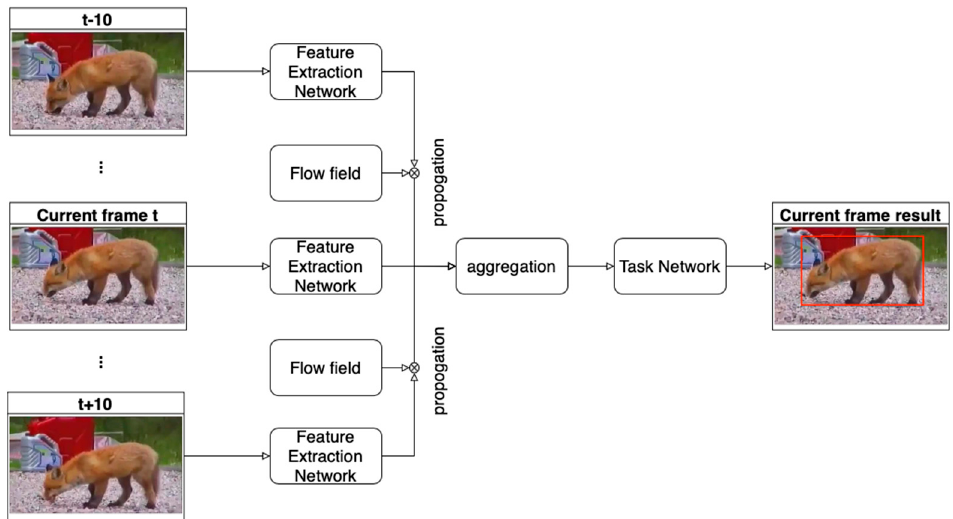
Figure 4. FGFA (flow-guided feature aggregation) framework [22].